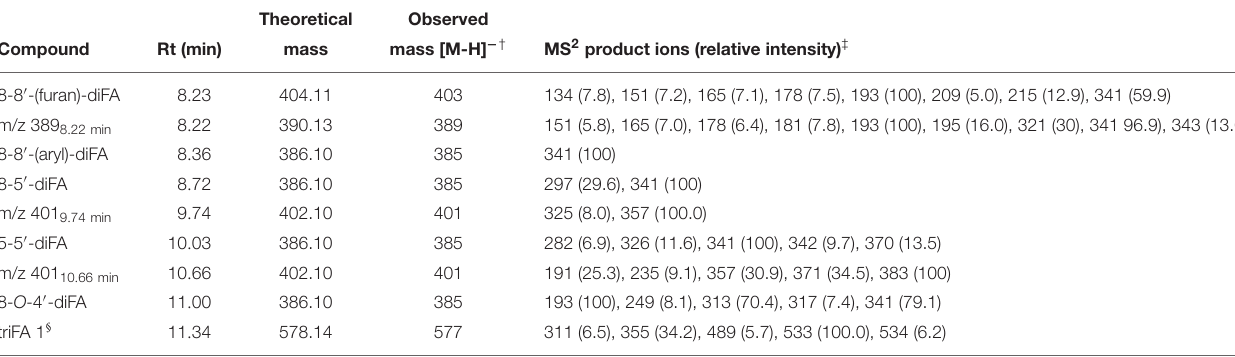
TABLE 2 | Esterified diferulic (diFAs) and triferulic (triFAs) acids analyzed by RP-UHPLC-UV-ESI-MS/MS. Theoretical